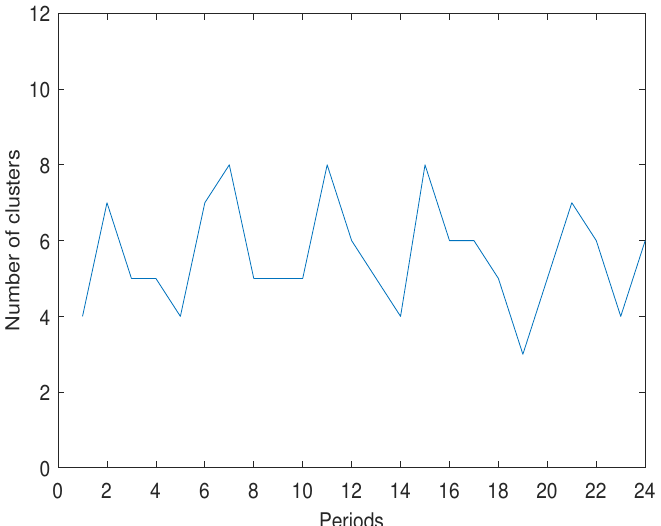
Figure 22. The number of clusters obtained by applying the density peak method for each time period in the case of time period = 20